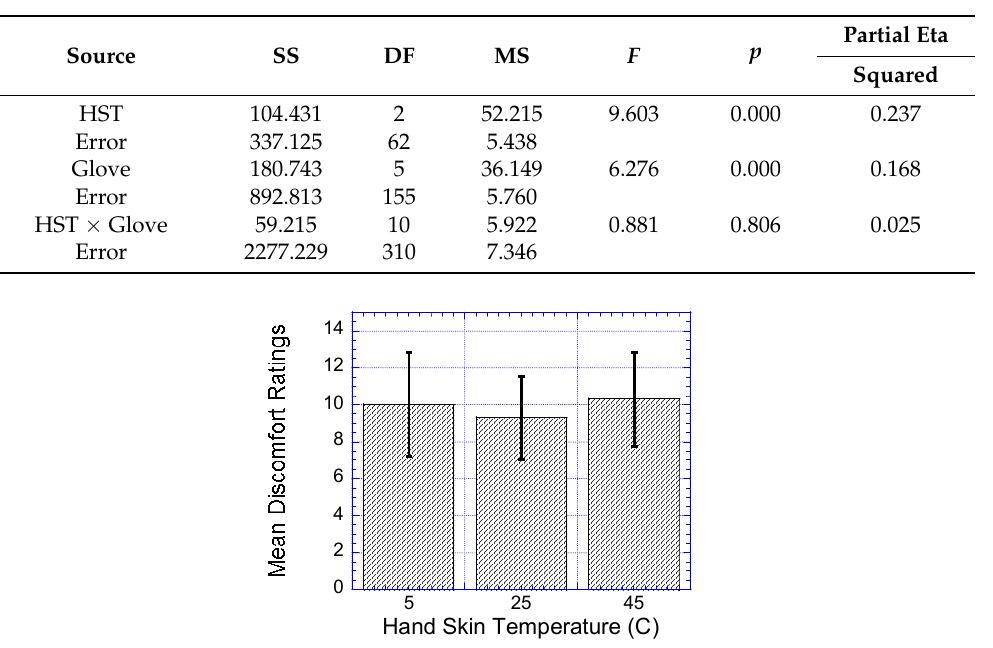
Figure 8. Effect of hand skin temperatures on discomfort ratings. Bar errors represent the standard deviations.